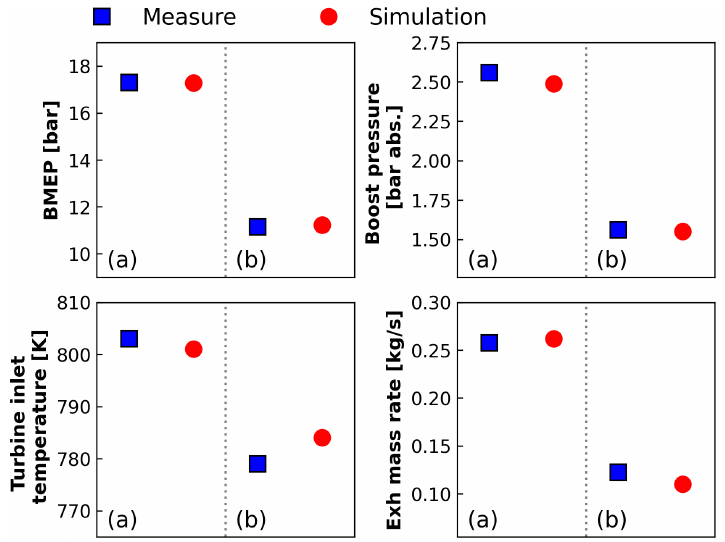
Figure 2. Calibration of engine performance and exhaust conditions at engine operating points: (a) 1300 rpm/17.8 nIMEP; (b) 900 rpm/11.5 nIMEP. The dots denote the cycle-averaged values of engine parameters over one cycle from engine tests and numerical